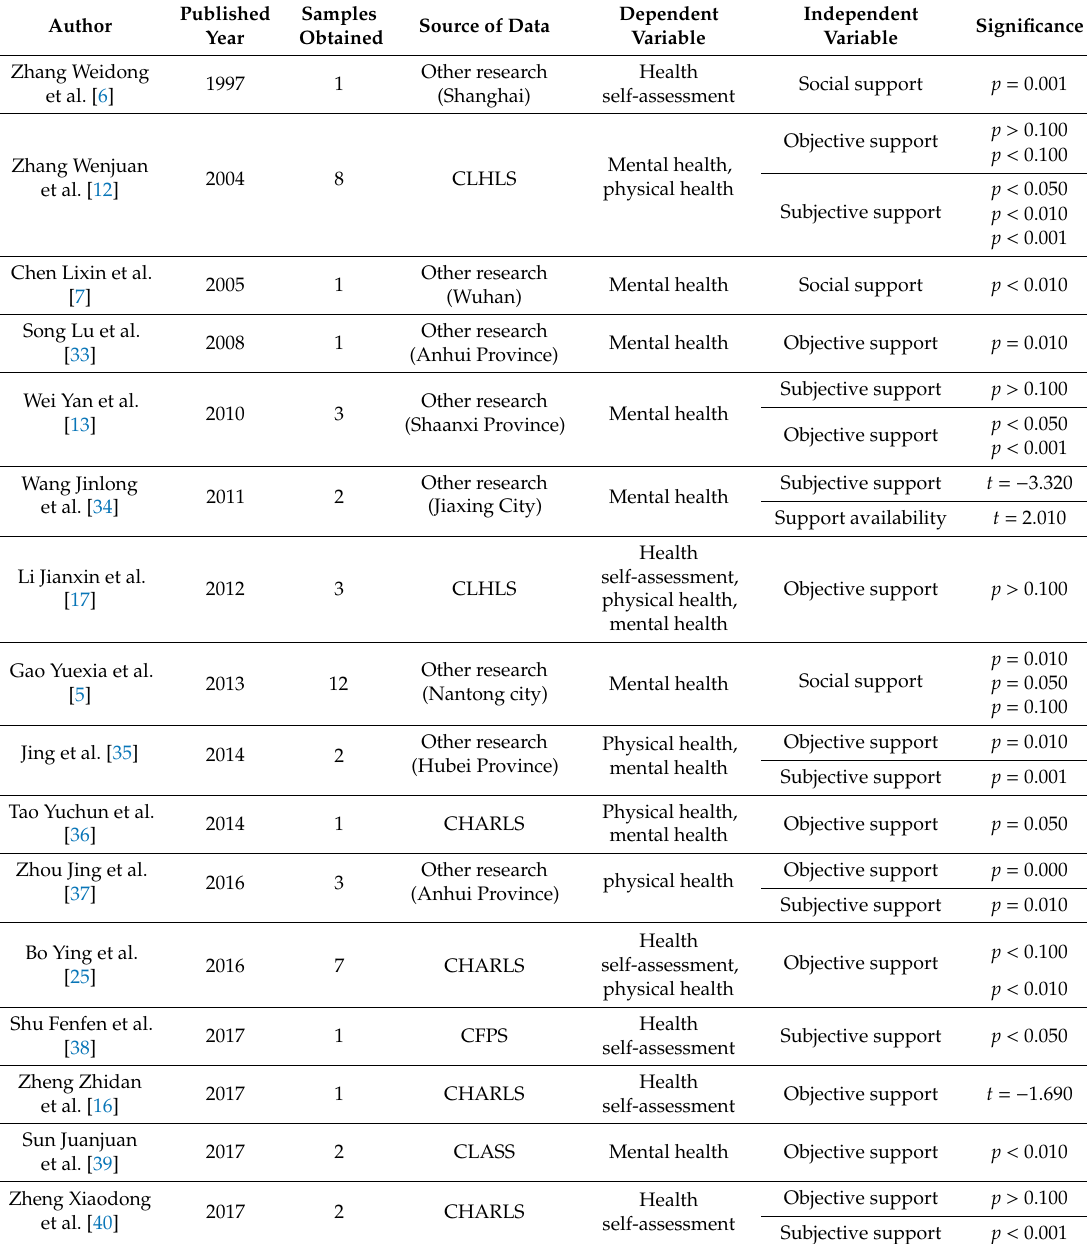
Table 1. Basic features of literature included